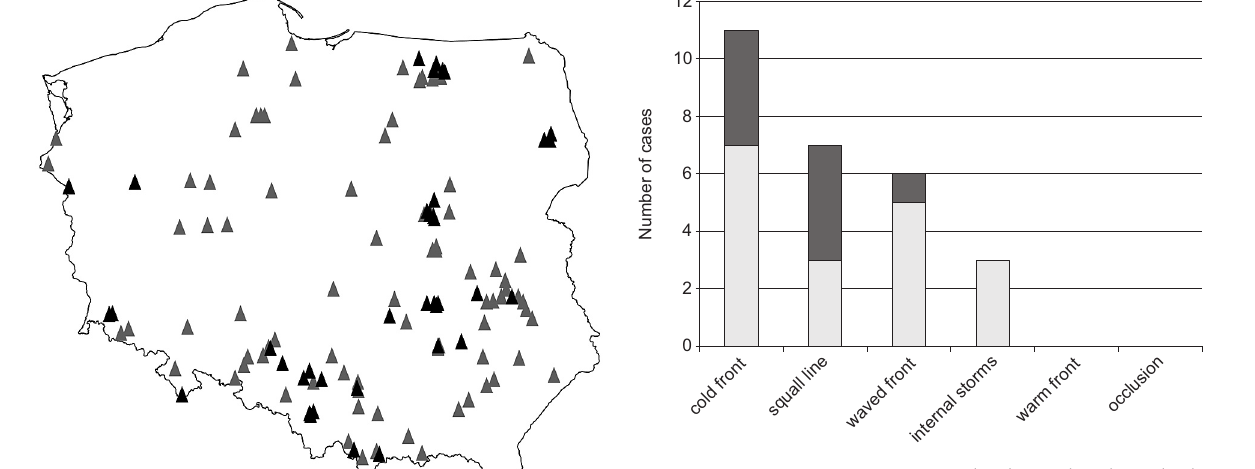
Fig. 4. Synoptic situation types in the days when large hail in 2012 in Poland was reported. Grey color indicate hail - Fig. 3. Large hail in Poland reported in 2012, grey triangles stones with diameter greater than 2 cm and less than 4 cm denote hailstone with diameter less than 4 cm, while black while black color indicate hailstones with diameter greater triangles denote hailstone with diameter greater or equal 4 or equal 4 cm (based on reports from ESWD) cm (based on reports from ESWD)